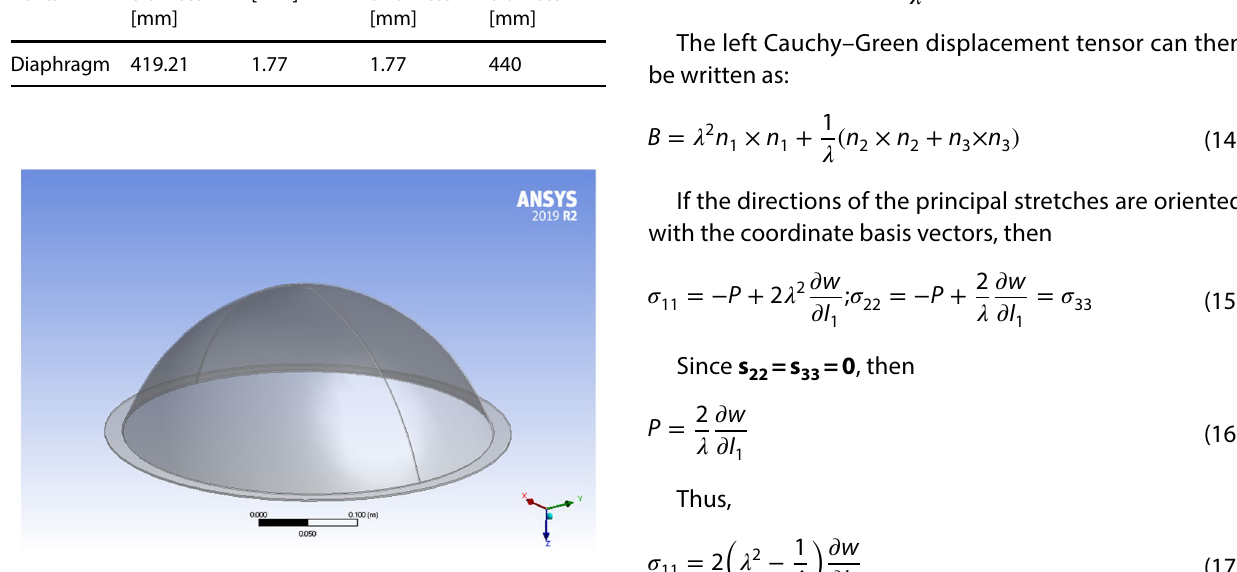
Table 1 Specification of diaphragm Compo- nents